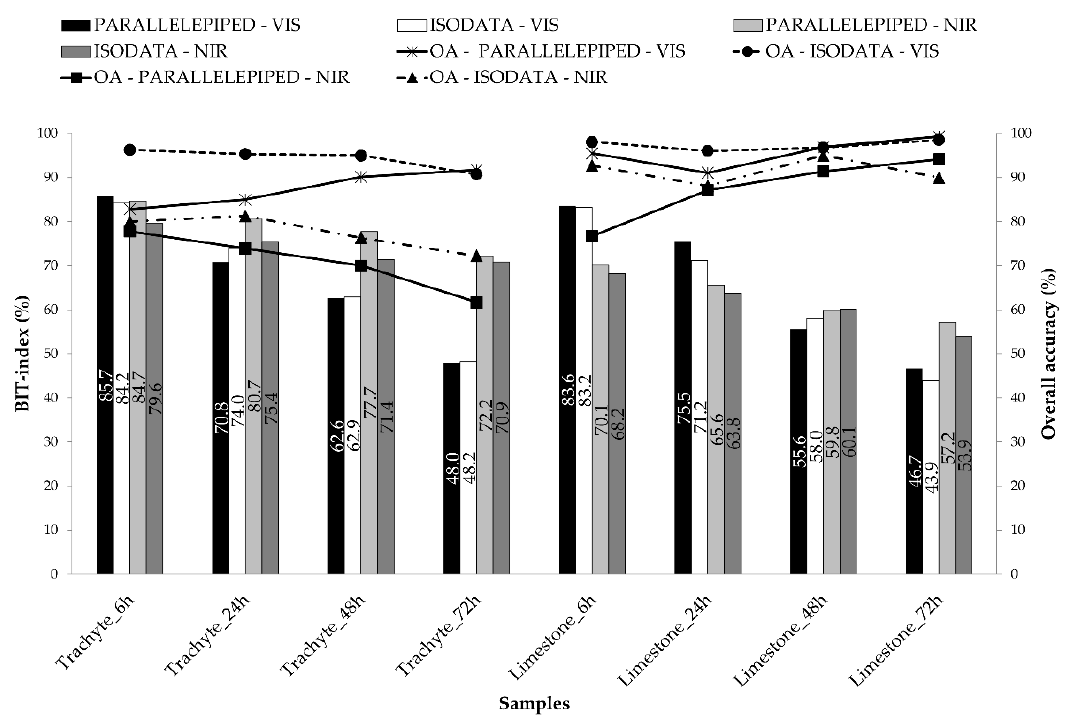
Figure 7. BIT index and accuracies calculated by ISODATA and parallelepiped classifications for limestone and trachytic aggregate mixtures in both VIS and NIR ranges.